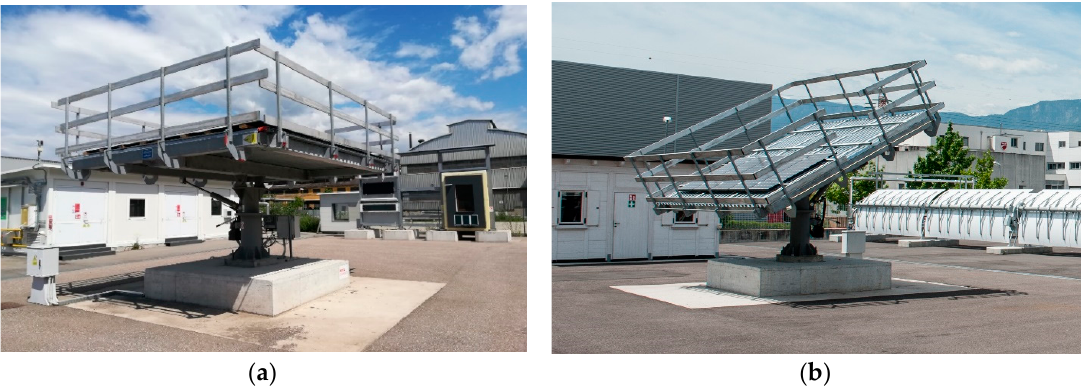
Figure 2. Outdoor PV integration lab: ( a ) view of roof in horizontal configuration and façade testbeds; and ( b ) detail of rotating configuration of the of the roof testbed.